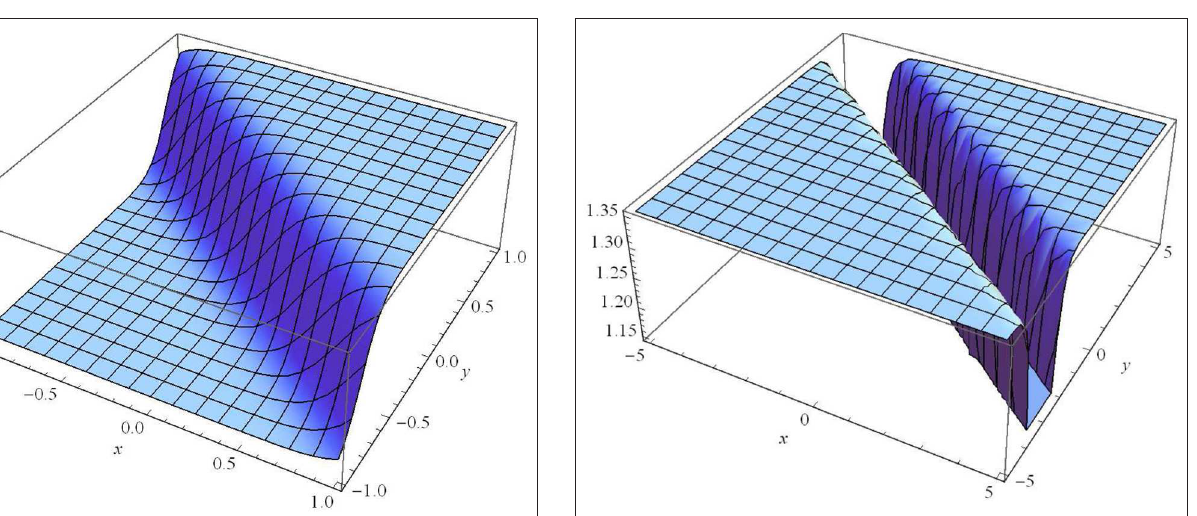
: ϑ I 8 ( x , y , t ) 1 =1, ϑ 2 = − 1, ϑ 3 = 1, µ 1 = 1, µ 2 = 1, µ 3 = 1, α 0 = 1, 1 | |